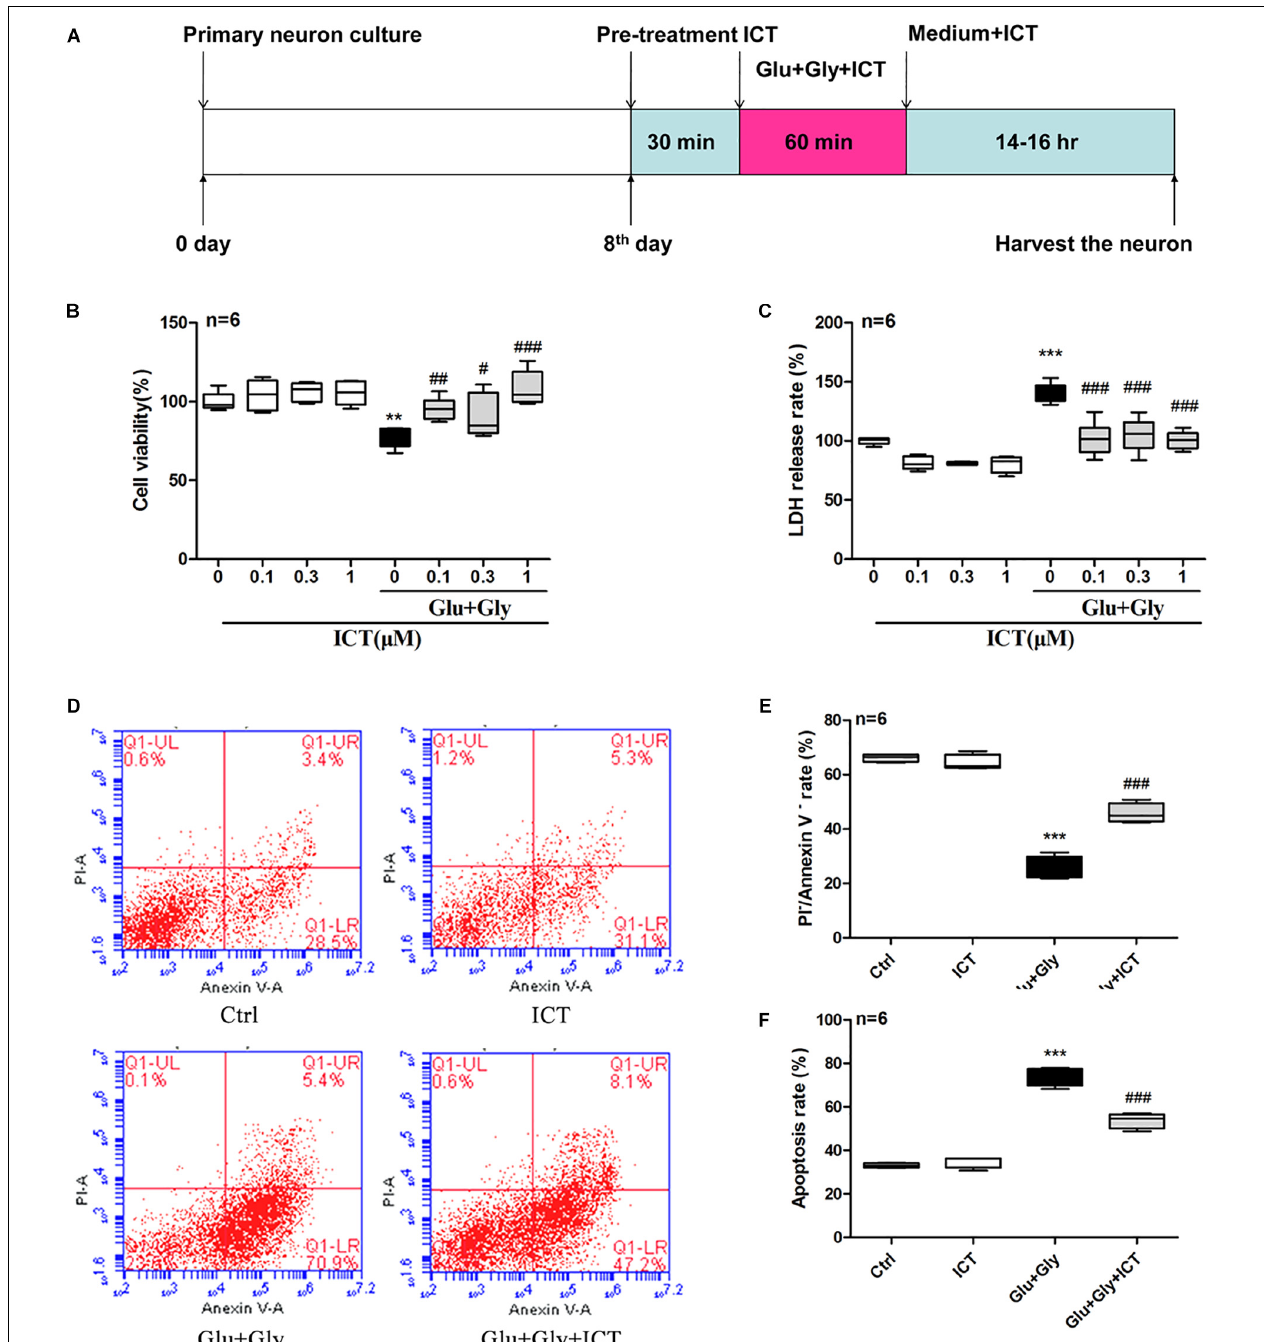
FIGURE 1 | ICT increases cell viability and reduces the rate of LDH release and apoptosis in cortical neurons after glutamate-induced injury. Treatment timeline for the glutamate-induced injury model and for ICT treatment of rat primary cortical neurons (A) : ICT treatment started 30 min prior to the onset of glutamate injury and continued until the time neurons were harvested, which was 14-16 hours after the glutamate injury treatment. Cell viability (B) and LDH release rate (C) from the eight different treatment groups: control, 0.1 µ M ICT, 0.3 µ M ICT, 1 µ M ICT, Glu+Gly, Glu+Gly+0.1 µ M ICT, Glu+Gly+0.3 µ M ICT, and Glu+Gly+1 µ M ICT, were expressed as the mean ± SEM ( n = 6). The annexin V/PI double staining results collected by flow cytometry are shown in scatter plots (D) . The percentages of surviving (E) and apoptotic (F) cells from the four treatment groups (control, 1 µ M ICT, Glu+Gly and Glu+Gly+1 µ M ICT) are shown as the mean ± SEM ( n = 6). One-way ANOVA followed by Newman-Keuls test, (B) : F = 8.832, (C) : F = 30.18, (E) : F = 142.5, (F) : F = 151.2; ** p < 0.01 and *** p < 0.001 vs. control; # p < 0.05, ## p < 0.01 and ### p < 0.001 vs.